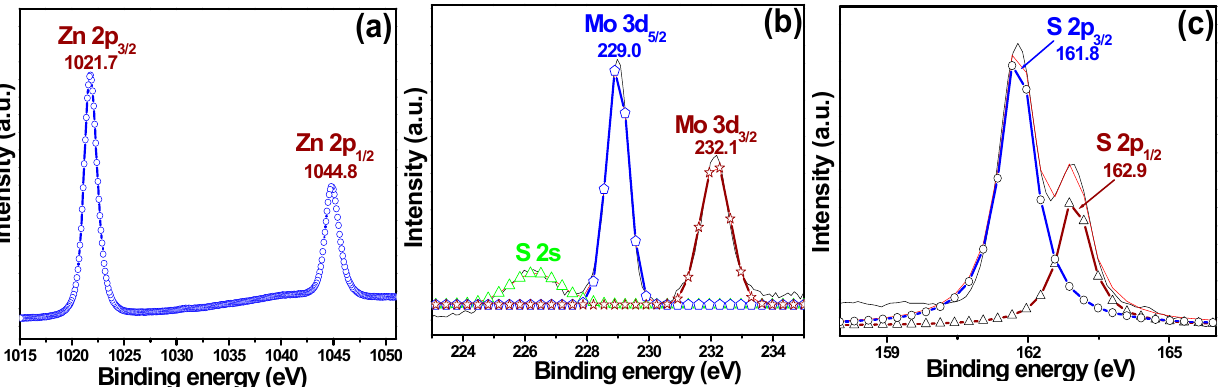
Figure 3 . X-ray photoelectron spectroscopy (XPS) results for the MZ nanocomposite: ( a ) Zn 2p spectrum and Gaussian-fitted ( b ) Mo 3d and ( c ) S 2p spectra.